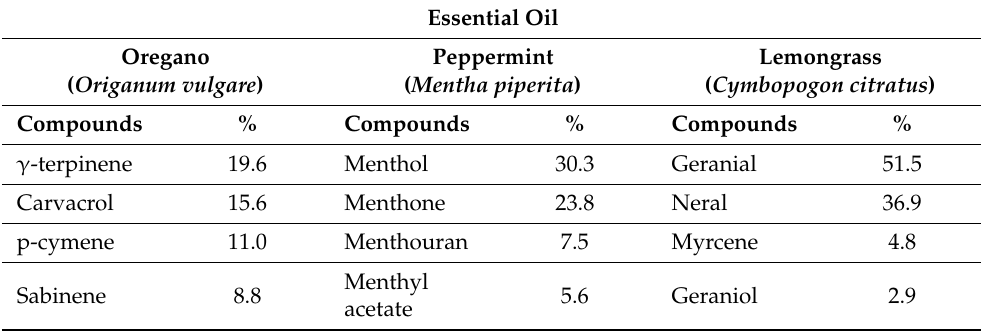
Table 5. The dominant compounds in selected essential oil (complete chemical composition was given in Supplementary Table S1).